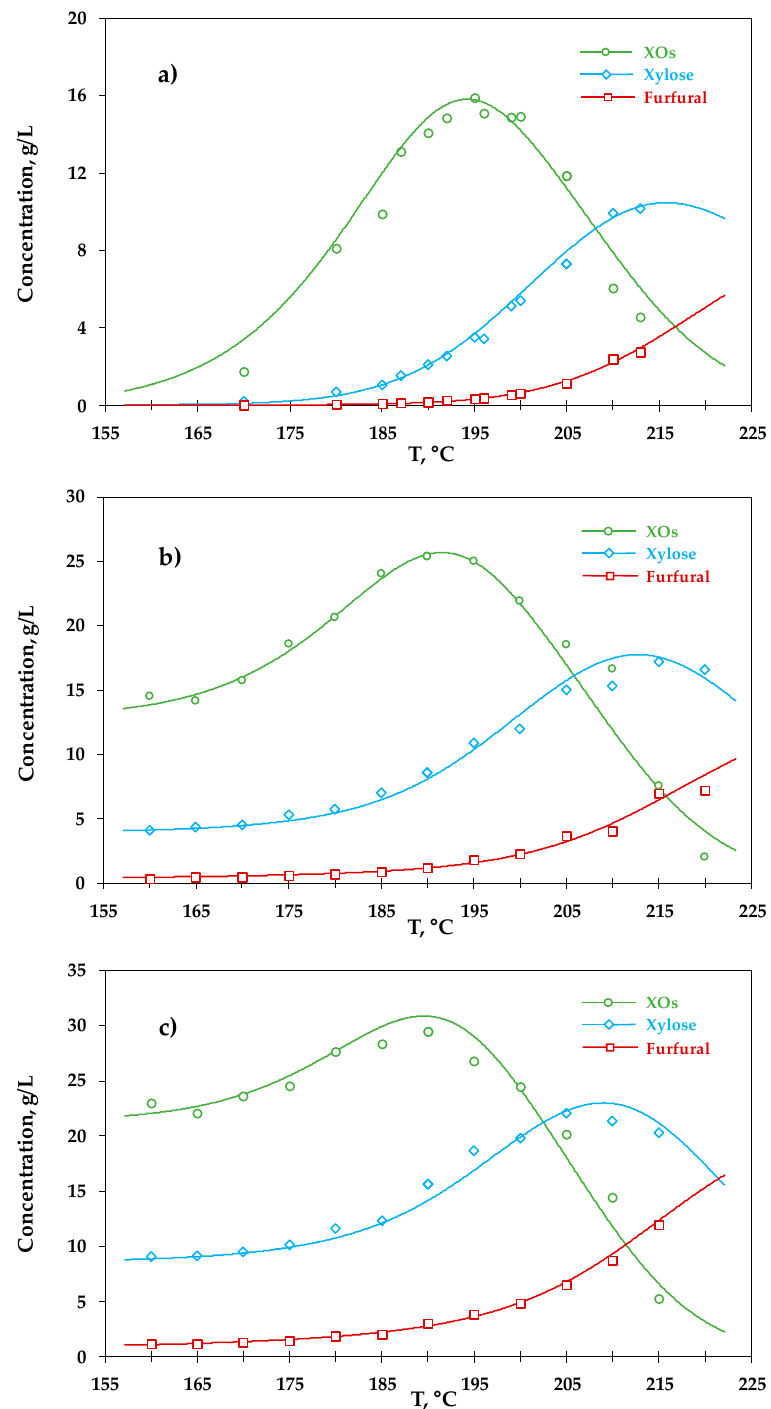
Figure 3. Experimental and calculated concentrations of the soluble products involved in the kinetic model. ( a ) Data determined for the first stage; ( b ) data determined for the second stage; ( c ) data determined for the third stage.